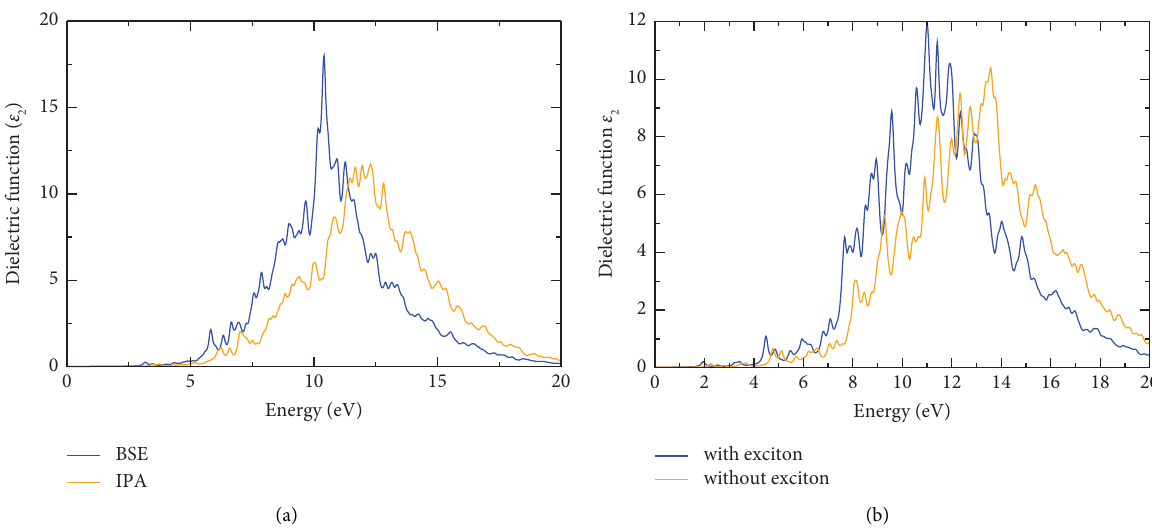
Figure 4: Optical spectra of imaginary dielectric function with arbitrary units: (a) the BSE and IPA result with respect to photon energy and (b) the excitonic efect in o-BC 2 N using the BSE algorithm in the polarization direction xyz (/or (111)).